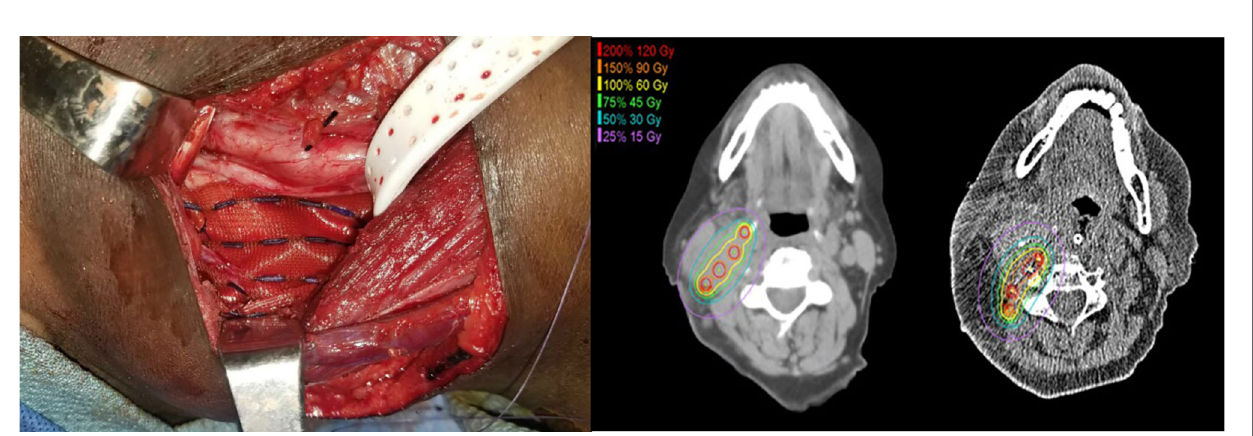
FIGURE 1 | Intraoperative adjustments were made for placement around major vessels, nerves, and bone. Components of the harvested fl ap were utilized to avoid direct contact of the Cs-131 seeds with critical structures, including the carotid